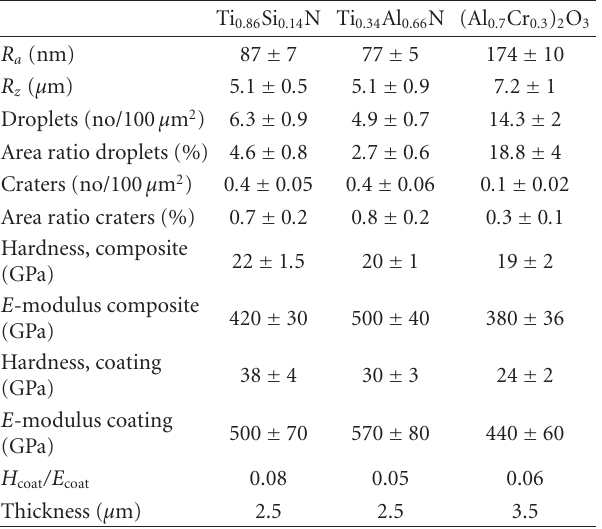
Table 2: Characteristic properties of the investigated coatings in the as-deposited condition.